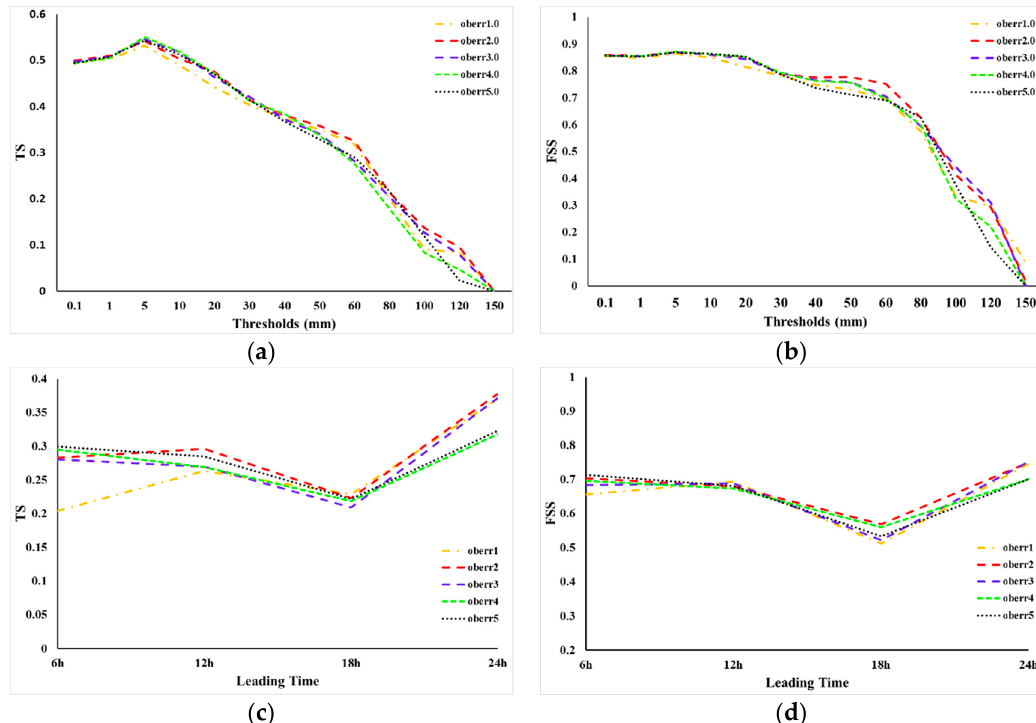
Figure 7. Sensitivity of rainfall forecast skill score to rainfall observation error. ( a ) Average TS of 24 h accumulated precipitation varied along the thresholds, ( b ) Average FSS of 24 h accumulated precipitation varied along the thresholds, ( c ) average TS with a threshold 12 mm every 6 h varied along the leading time, and ( d ) average FSS with a threshold of 12 mm every 6 h varied along the leading time.